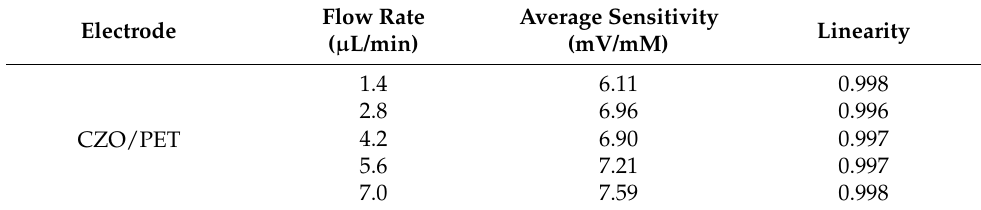
Figure 7. Response curves of the AgNWs/CZO sensor under different flow rates. Table 2. Sensing performances of the CZO sensor.